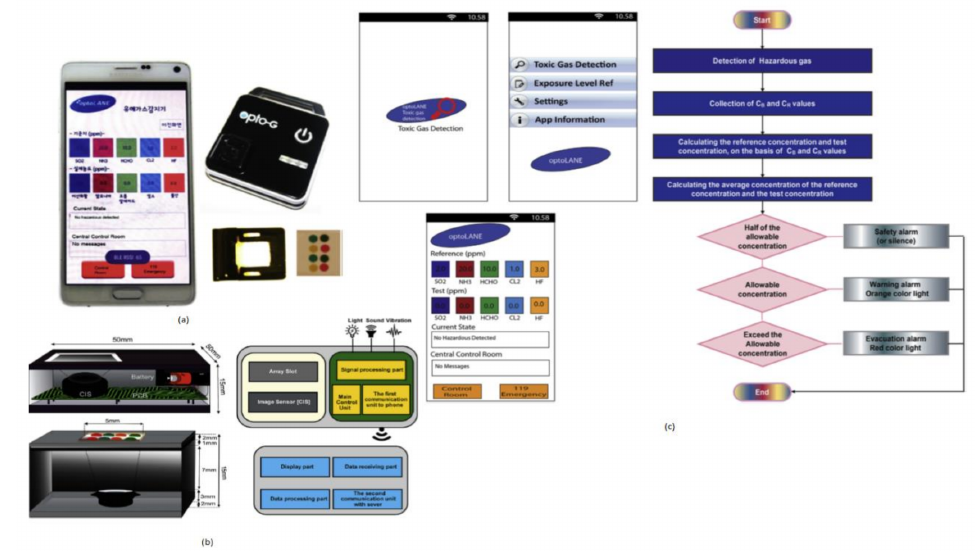
Figure 13. ( a ) Smartphone-based toxic gas detection system. ( b ) Instrumental setup for toxic gas de- tection microarray reader. ( c ) Stepwise illustration of smartphone application “Toxic Gas Detection.” Figure adapted with permission from [20].